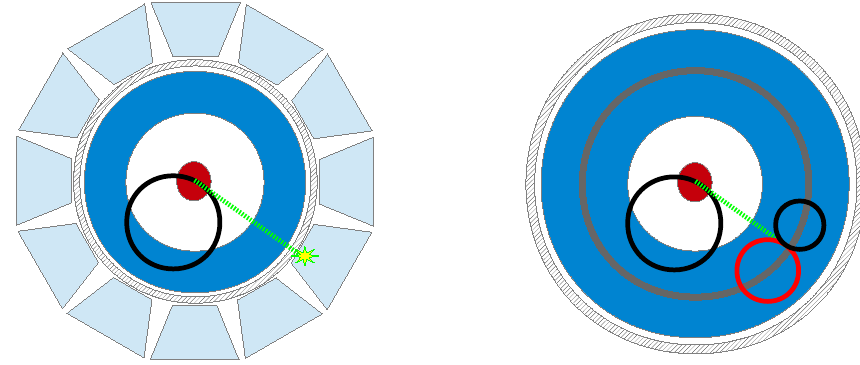
Figure 1. Two possible approaches for the µ → e γ search: calorimetric reconstruction of photons ( left ) and conversion of photons to e + e − in a layer of dense material ( right ), followed by a spectrometer to track the charged particle pair. In both cases, the positron is tracked in a magnetic